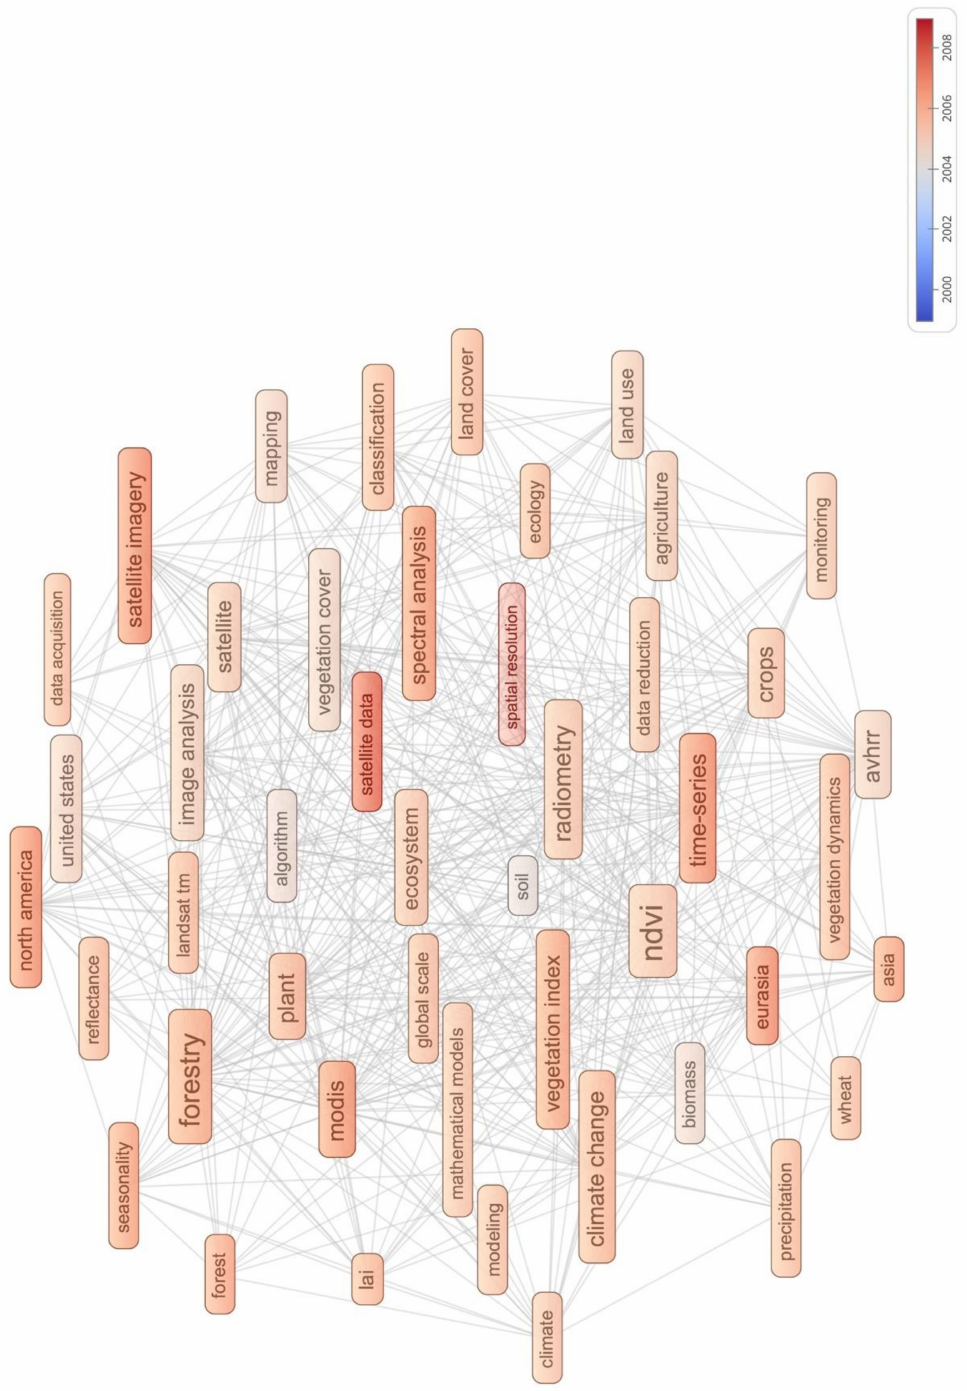
Figure 3. Network mapping of the keywords most used (occurrence threshold = 20) in the rs + pheno research in 1999–2008. Color bar indicates the year in which each keyword was mainly used. Lines represent the link strength between two terms (minimum link strength =